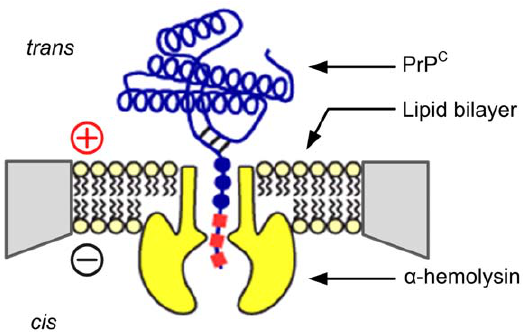
Figure 1. Cartoon illustrating the capture of an individual PrP C molecule into an a -hemolysin nanopore. PrP C is electrophoreti- cally driven into the a -HL nanopore (voltage polarity given by the plus and minus signs) via its positively charged N-terminus. The trans chamber contains 0.3 M KCl, 45 mM NaPO 4 , 10 mM HEPES, pH 8.0 solution at a PrP C concentration of 13.4 m M. The cis chamber contains 3 M KCl, 10 mM HEPES, pH 8.0 solution. The salt-concentration gradient across the pore generates an osmotic flow from trans -to- cis and enhances the electric field around the entrance of the trans -side of the pore [30,31] thereby substantially increasing the nanopore-capture rate of PrP C in solution relative to symmetric salt conditions [30,31]. Experiments were conducted (and maintained) at a temperature of 20 u C 6 0.1 u C.